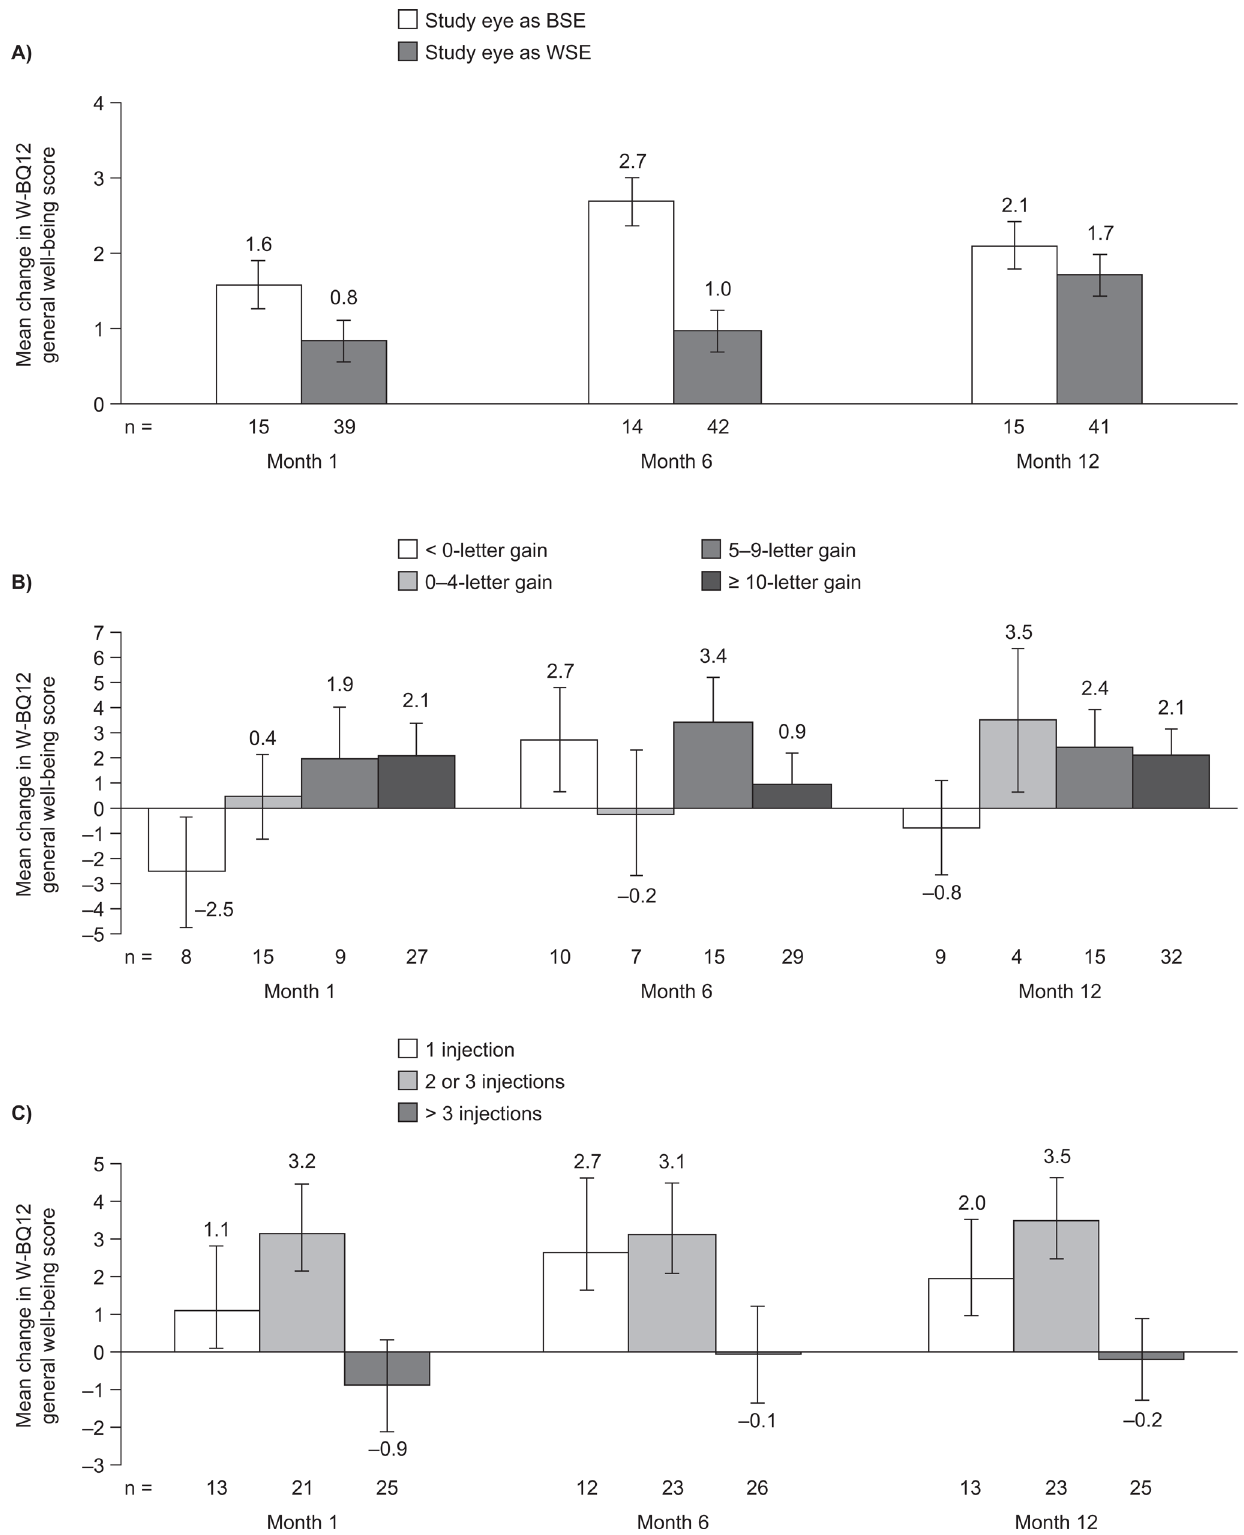
Fig 4. Mean change in W-BQ12 general well-being scores. (A) BSE/WSE, (B) BCVA improvement and (C) number of injections. Data are shown as mean ± standard error. BCVA, best-corrected visual acuity; BSE, better-seeing eye; W-BQ12, 12-item Well-Being Questionnaire; WSE, worse-seeing eye.